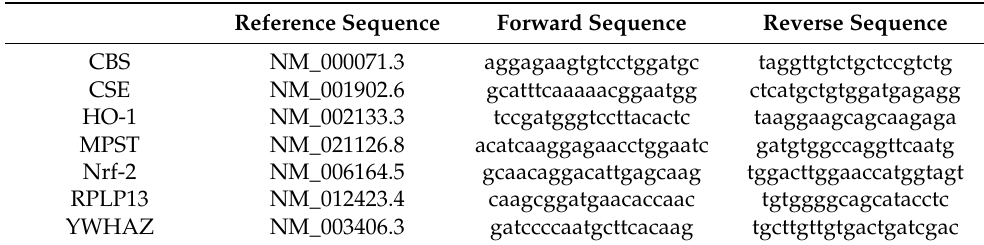
Table 1. Sequence of primers used to analyse gene expression. CBS, cystathionine β -synthase; CSE, cystathionine γ -lyase; HO-1, heme oxygenase-1; MPST, 3-mercaptopyruvate